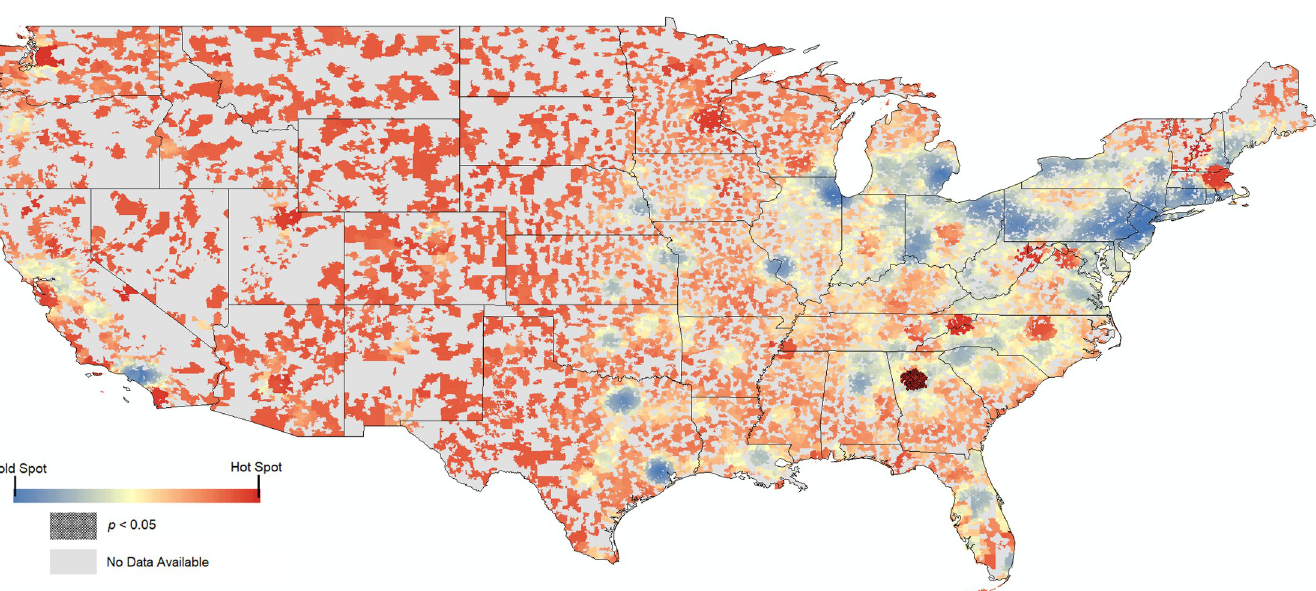
PLOS ONE | https://doi.org/10.1371/journal.pone.0252656 June 2,